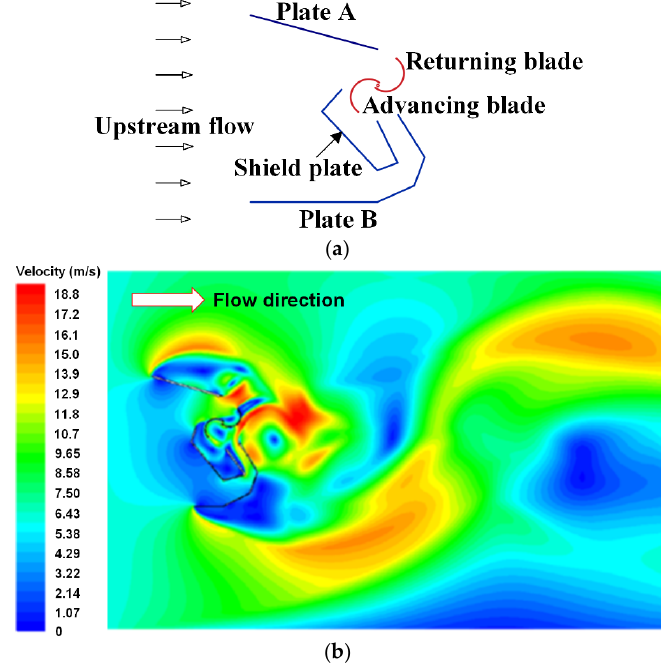
Figure 6. Configuration of three auxiliary plates [32]. ( a ) Schematic view of complex auxiliary plates; ( b ) Velocity distribution.